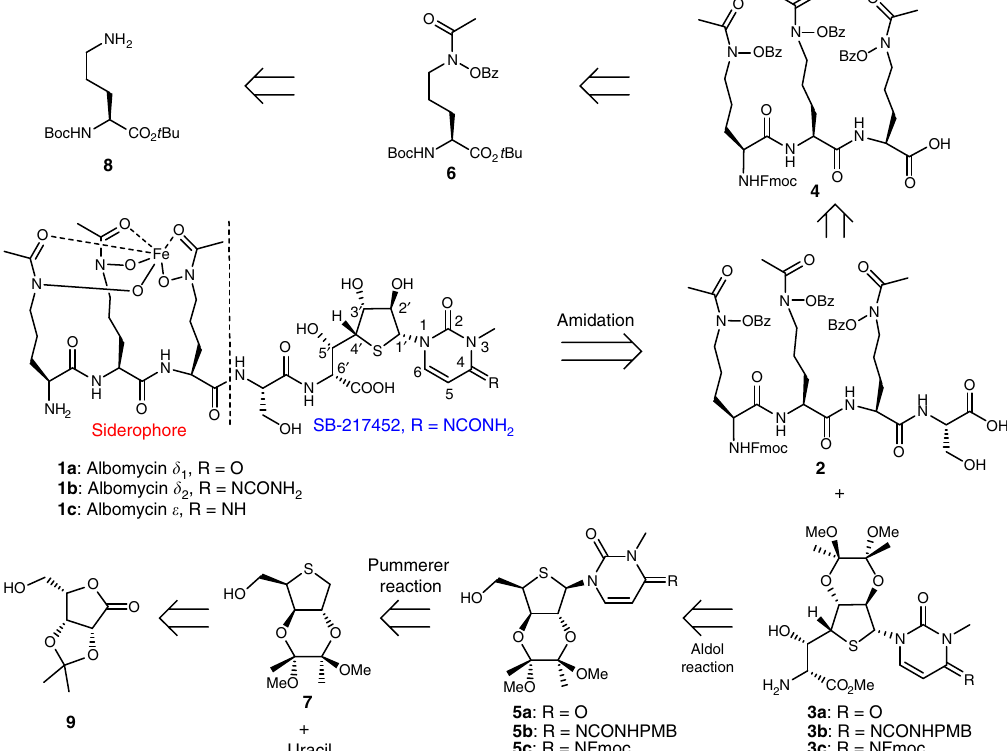
Fig. 1 Chemical structures of albomycins δ 1 , δ 2 , and ε , and their synthetic strategies. The key disconnections involve a Pummerer reaction for nucleobase introduction and an aldol reaction to expand the side chain of thionucleoside. tBu tert -butyl, Bz benzoyl, Fmoc fl uorenylmethyloxycarbonyl, PMB p